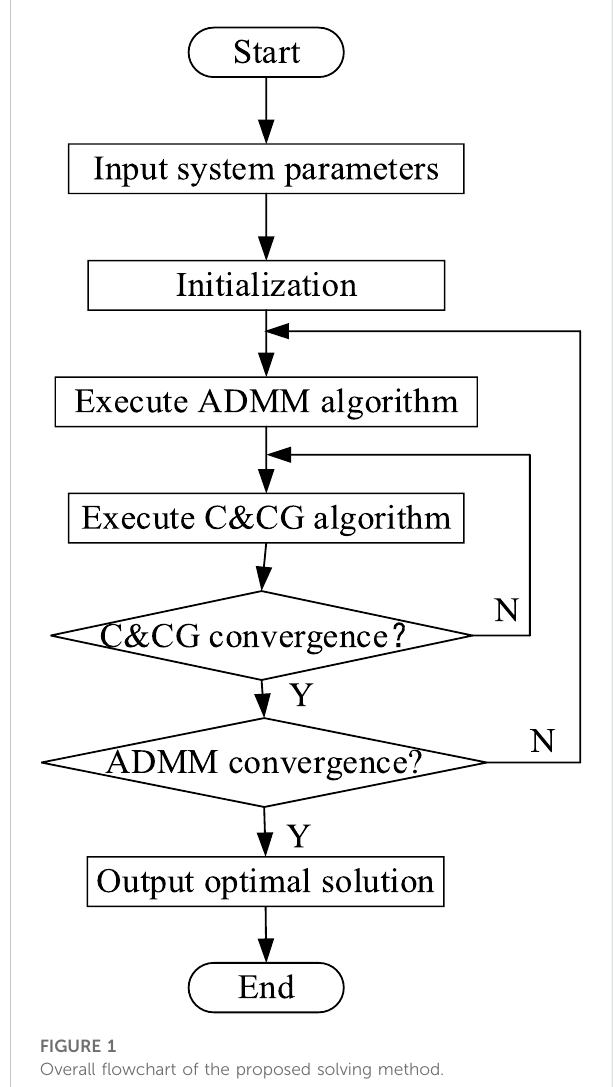
FIGURE 1 Overall fl owchart of the proposed solving